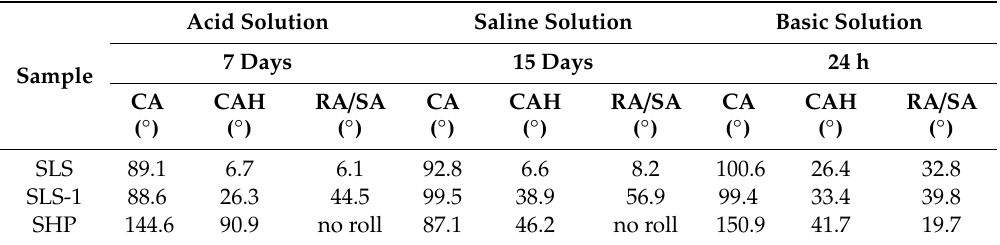
Table 3. Significant wettability results after durability test in wet chemicals for SLS, SLS-1 and SHP.